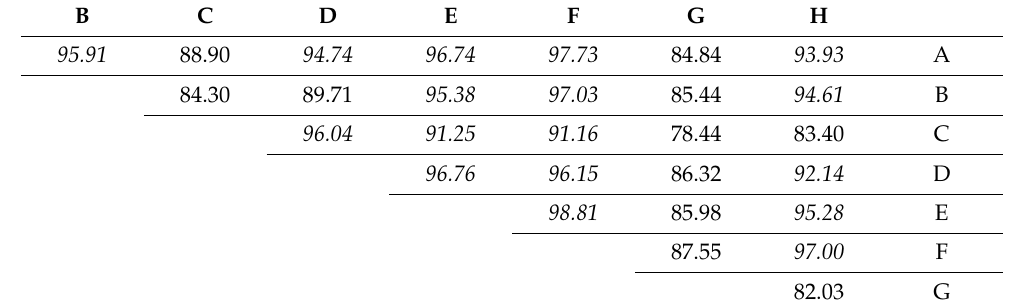
Table 9. Values of %PV (%).